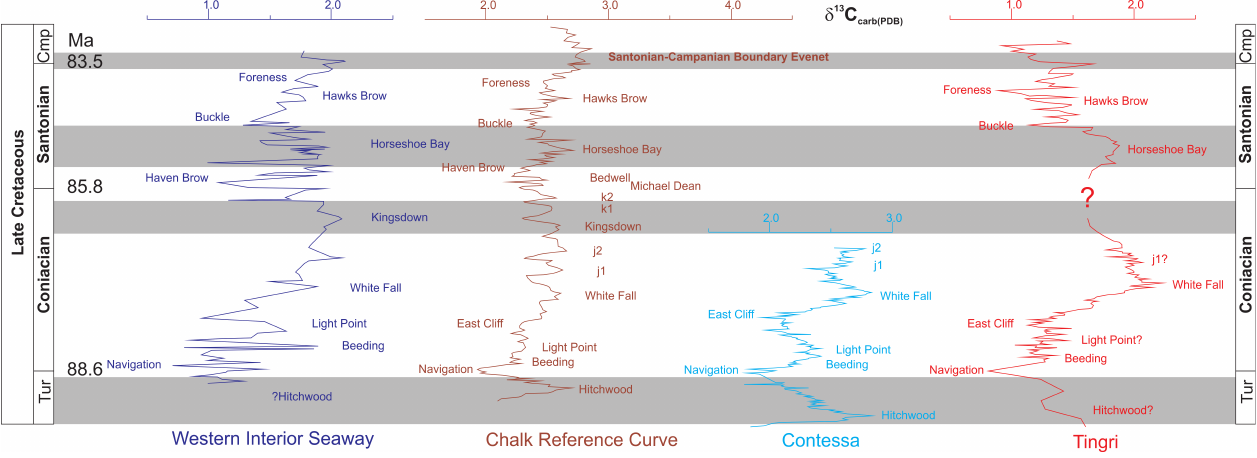
Fig. 2. Carbon isotope curves and correlations of carbon isotope events from inferred OAE 3 sites of the Western Interior (Pratt et al., 1993, stratigraphy according to Locklair et al., 2011), the English Chalk reference curve (Jarvis et al., 2006, based on several sections), and two Tethyan sections: the Contessa/Vispi quarry section in Italy (Stoll and Schrag, 2000) and the Tingri section in Tibet (Wendler et al., 2009). Carbon isotope curves are time-calibrated on a chronostratigraphic scale by using the Turonian–Coniacian boundary and the correlated negative carbon isotope event (Navigation event of Jarvis et al., 2006; see also Walaszczyk et al., 2010), the Coniacian–Santonian boundary, and the Santonian–Campanian boundary and its positive carbon isotope event (Santonian/Campanian Boundary Event of Jarvis et al., 2006; see also Gale et al., 2007 and Wendler et al., 2009) as tie points, and numerical ages from Ogg et al. (2004), Locklair and Sageman (2008) and TimeScaleCreator 5.3